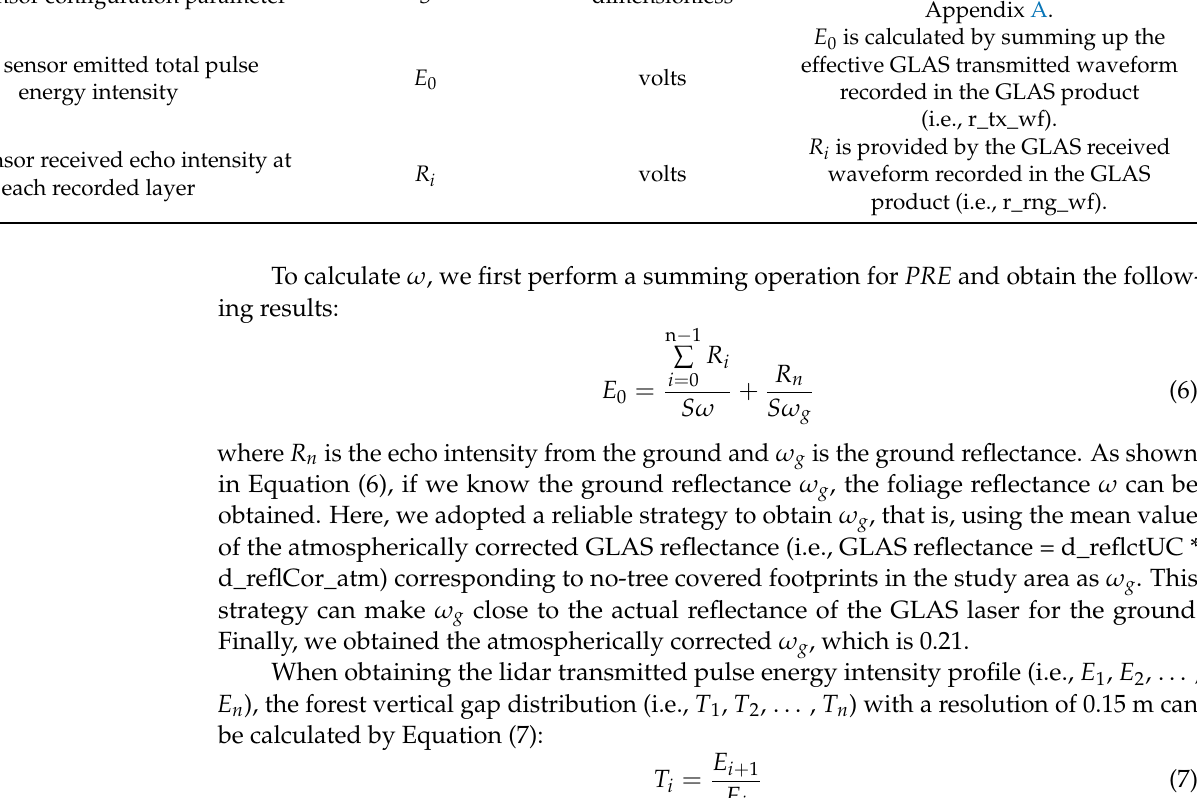
Calculation process of S is shown in Appendix